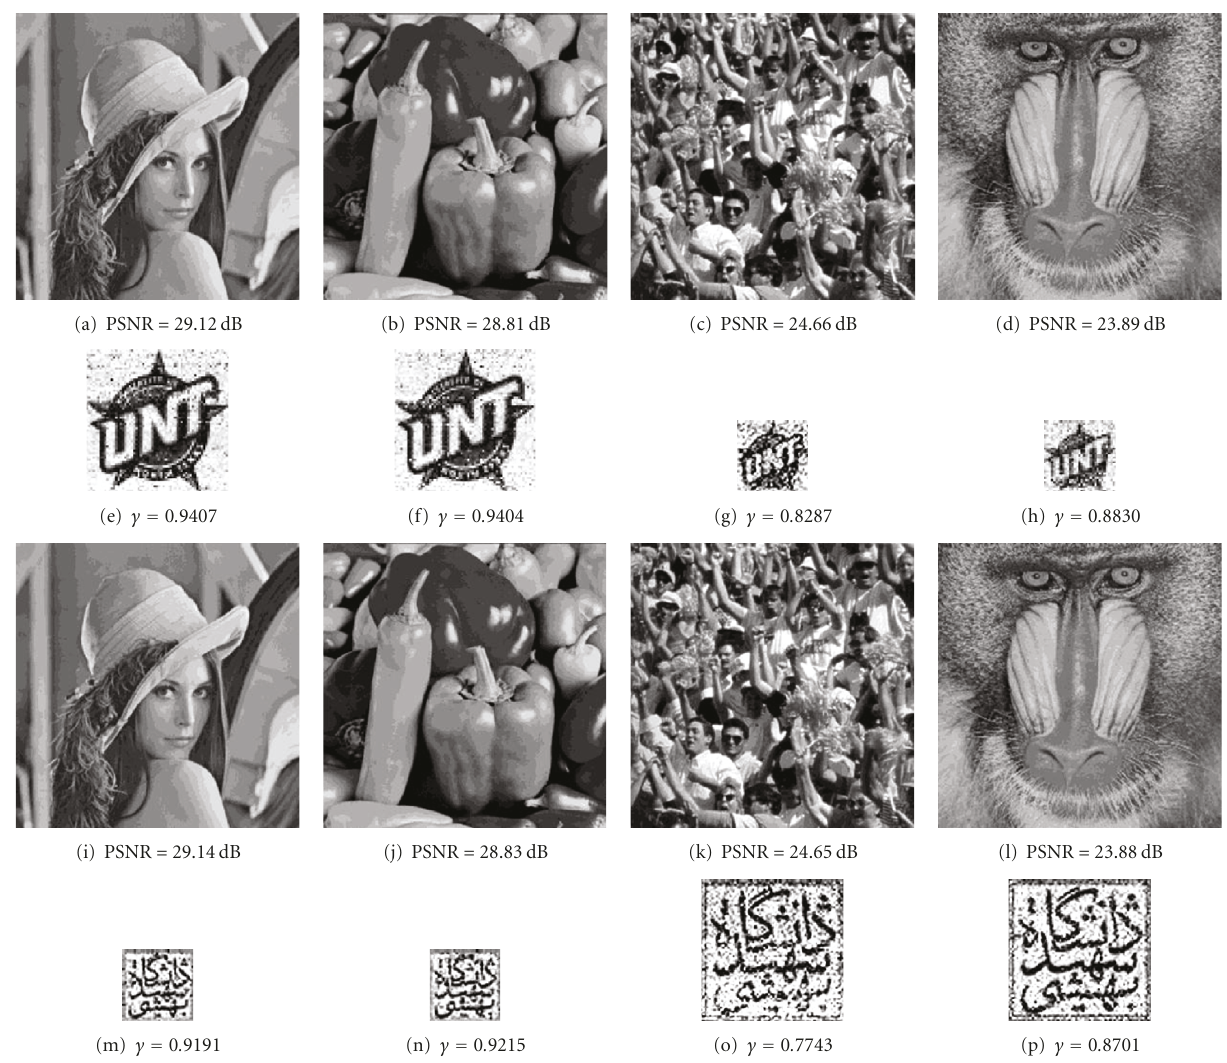
Figure 20: (a) and (b) Lena and Peppers watermarked images with 256 × 256 watermark image as shown in Figure 11(b) after Bluring with radius 3, (e) and (f) the extracted watermarks with size 256 × 256 from (a) and (b), respectively. (c) and (d) Crowd and Baboon watermarked images with 128 × 128 watermark image as shown in Figure 11(b) after Bluring, (g) and (h) the extracted watermarks with size 128 × 128 from (c) and (d), respectively. (i) and (j) Lena and Peppers watermarked images with 128 × 128 watermark image as shown in Figure 11(d) after Bluring, (m) and (n) the extracted watermarks with size 128 × 128 from (i) and (j), respectively. (k) and (l) Crowd and Baboon watermarked images with 256 × 256 watermark image as shown in Figure 11(d) after Bluring, (o) and (p) the extracted watermarks with size 256 × 256 from (k) and (l),